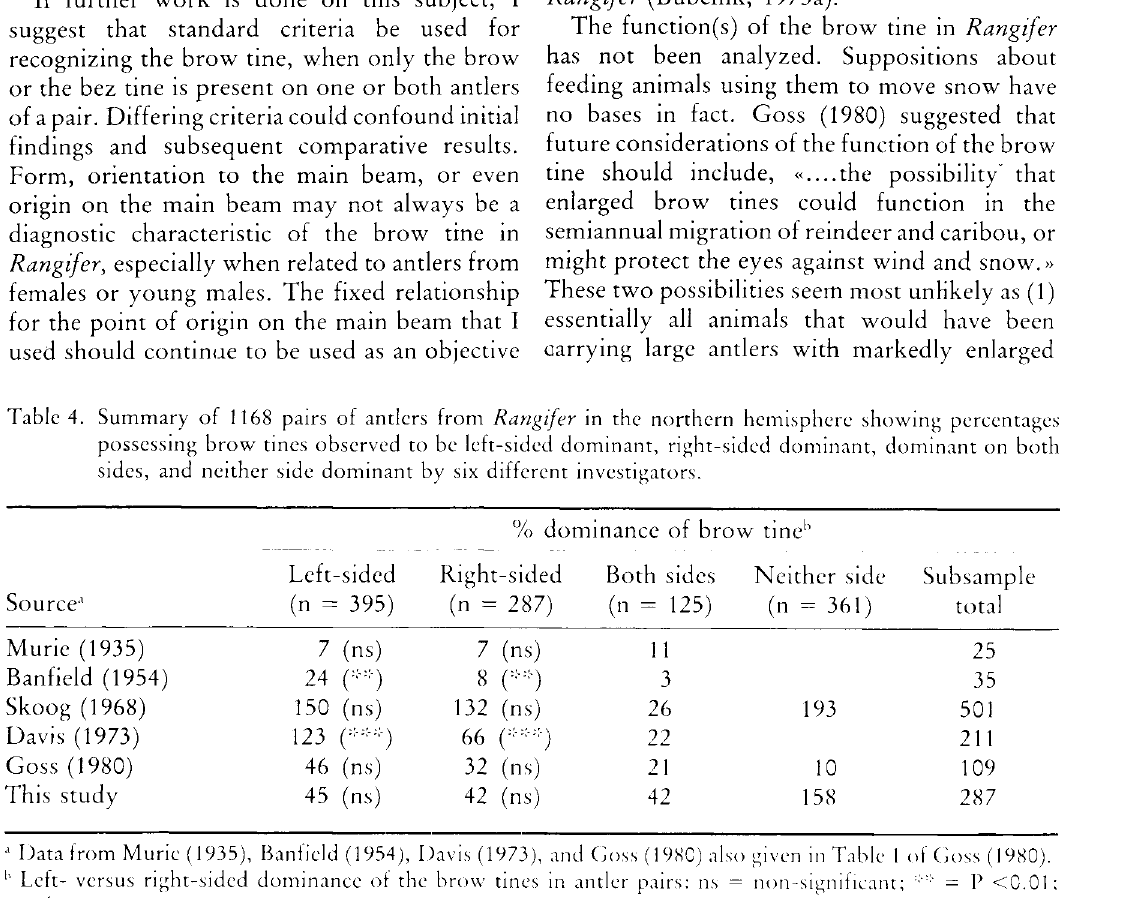
Table 4. Summary of 1168 pairs of antlers from Rangifer in the northern hemisphere showing percentages possessing brow tines observed to be left-sided dominant, right-sided dominant, dominant on both sides, and neither side dominant by six different